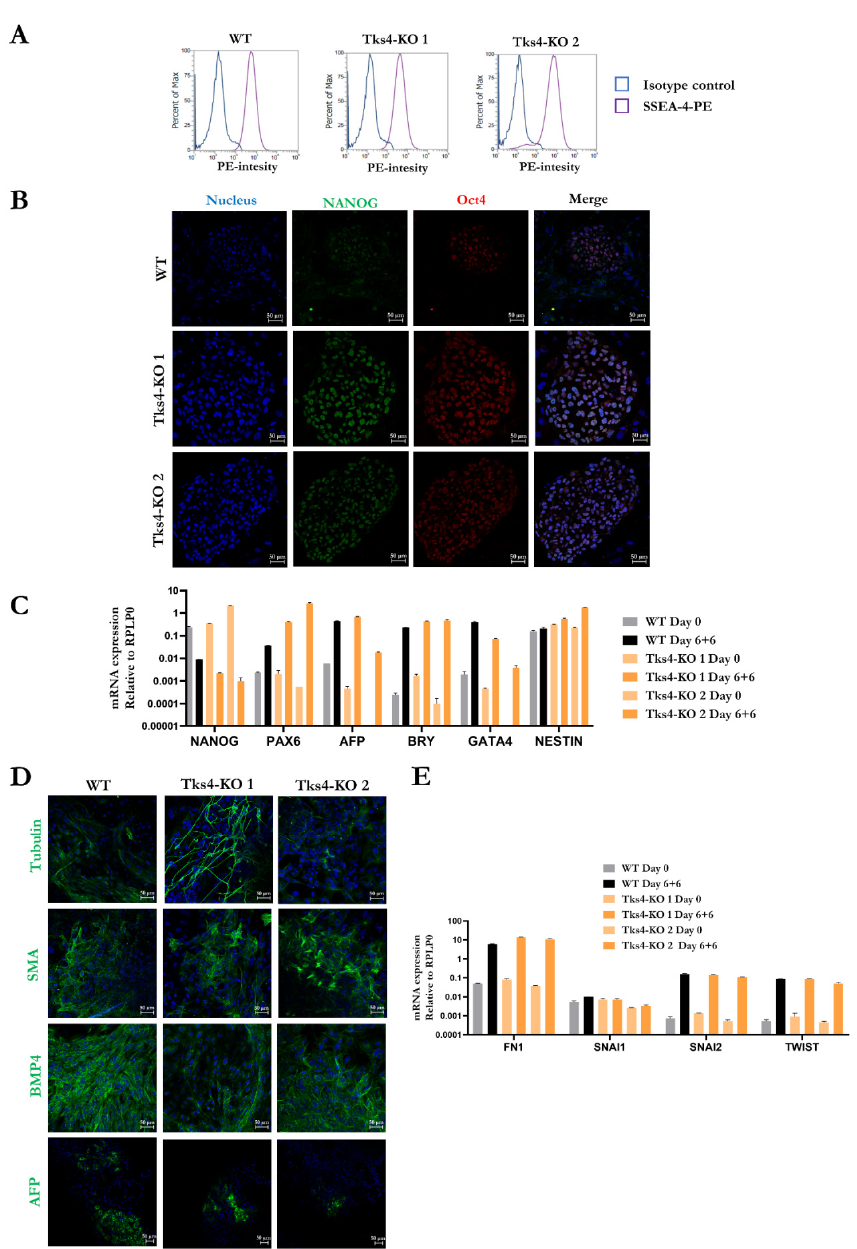
Figure 2. Assessment of the pluripotency of the Tks4-KO HUES9 cells. ( A ) The SSEA4 expression levels in WT cells and the Tks4-KO cells were analysed via flow cytometry. Isotype controls were used as a negative control on each plot; ( B ) Immunofluorescent staining showing the Oct4 (red) and Nanog (green) expression levels in undifferentiated cells; ( C ) The expression levels of the pluripotency- related genes Nanog and differentiation-related genes Pax6, alpha fetoprotein (AFP), brachyury (BRY), GATA4, and NESTIN were analysed via RT-qPCR to assess the efficiency of spontaneous differentiation. Gene expression was normalized to the value of RPLP0; ( D ) The differentiation potential into all the three germ layers of WT cells and the Tks4-KO cells were assessed via ICC of β -III-tubulin, smooth muscle actin (SMA), bone morphogenetic protein 4 (BMP4), and AFP after 6 + 6 days of the spontaneous differentiation. Nuclei were counterstained with DAPI (blue); ( E ) Expression levels of EMT-related markers (Fibronectin (mRNA:FN1), Snail1 (mRNA:SNAI1), Snail2 (mRNA:SNAI2), Twist (mRNA:TWIST)) were measured via RT-qPCR and compared to those of the original stem cell lines (day 0) within the spontaneous differentiated derivatives (day 6 + 6 of